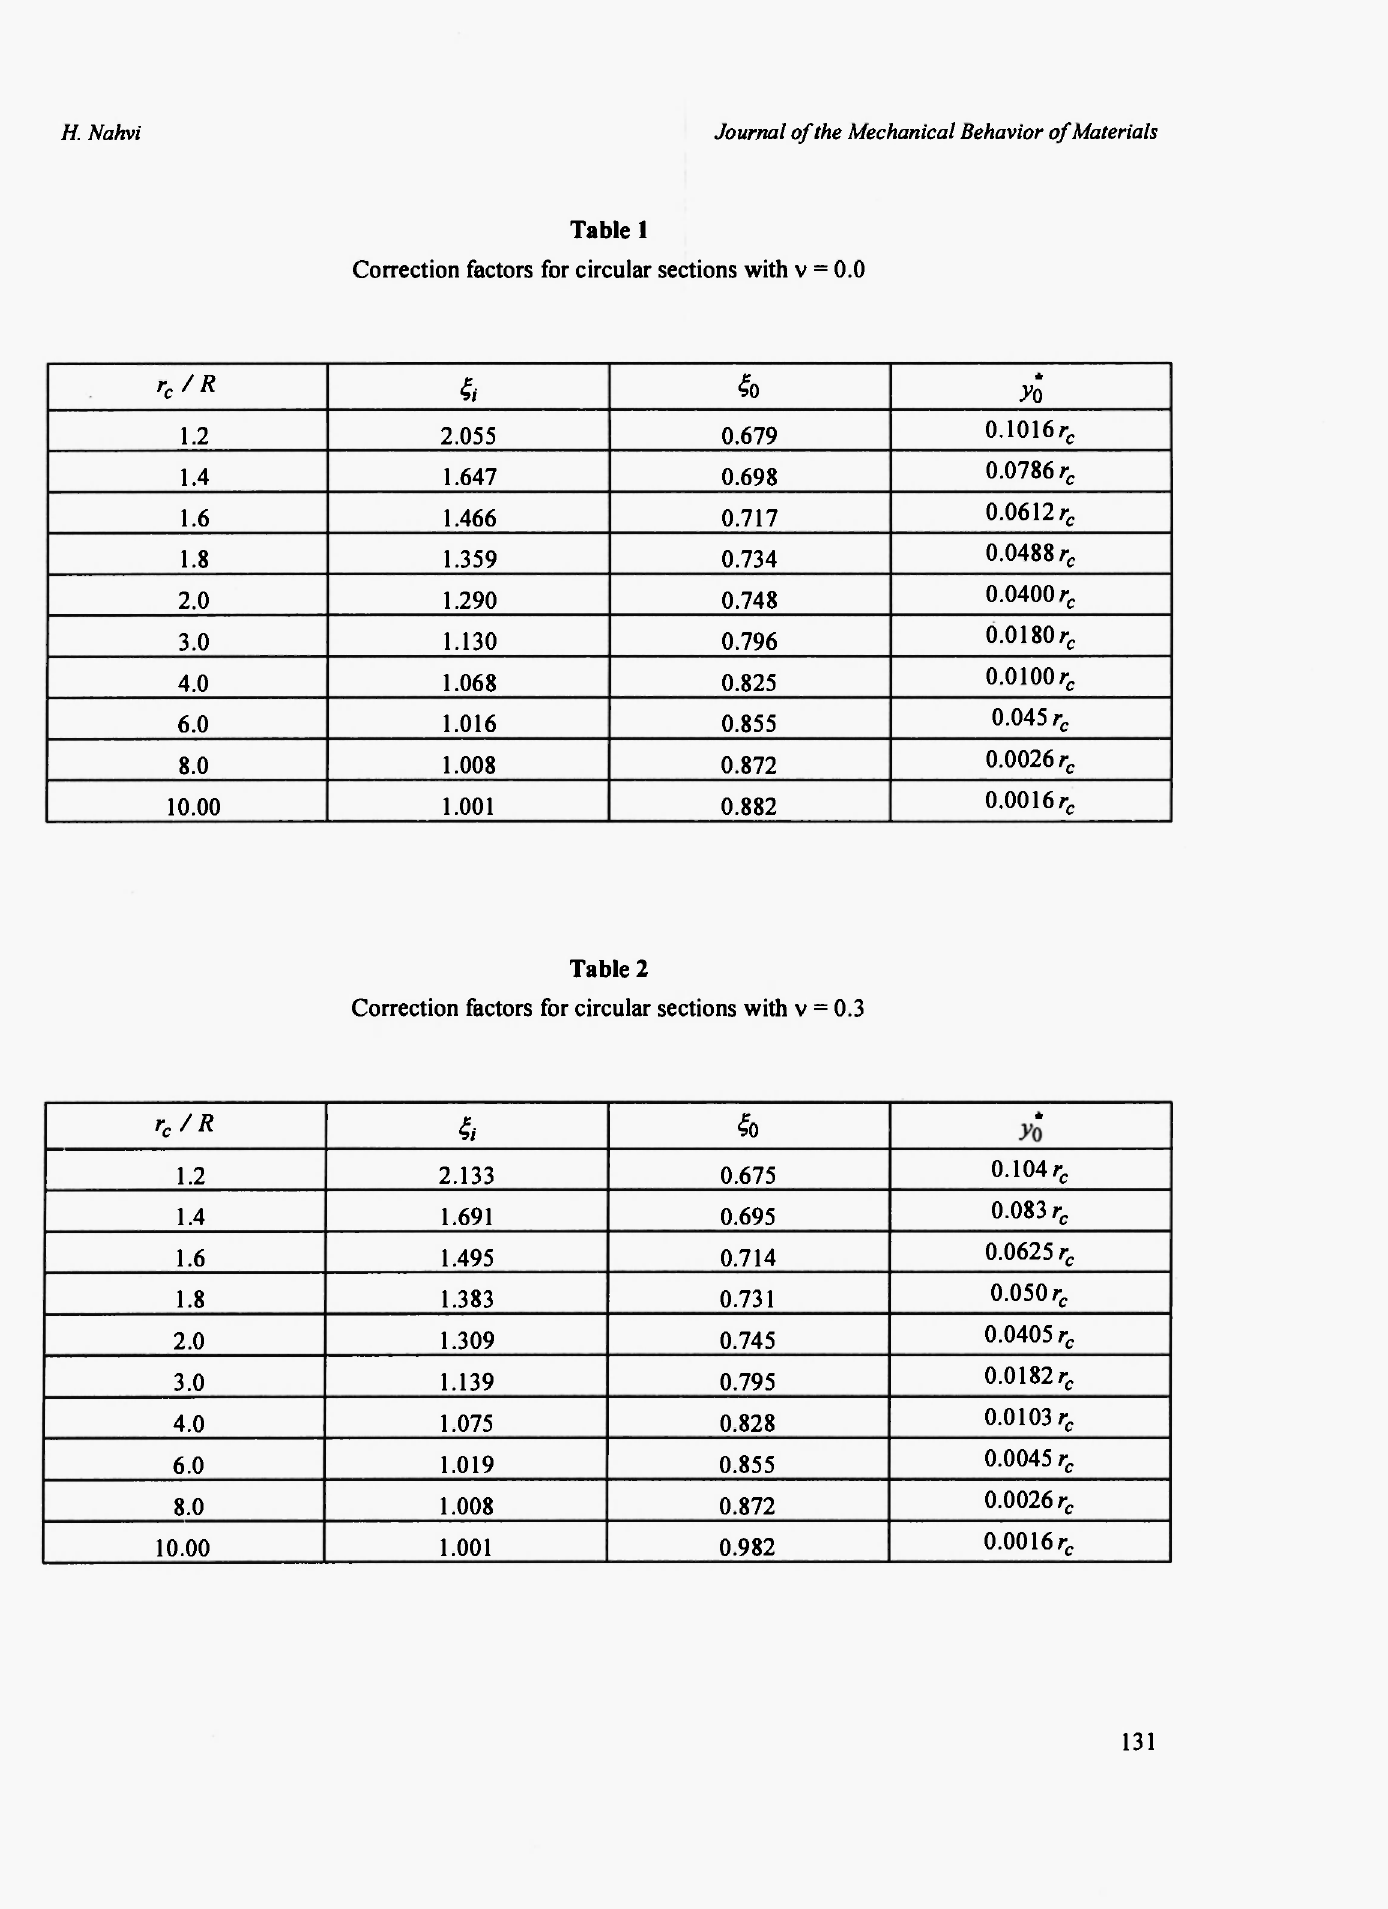
Correction factors for circular sections with ν = 0.0